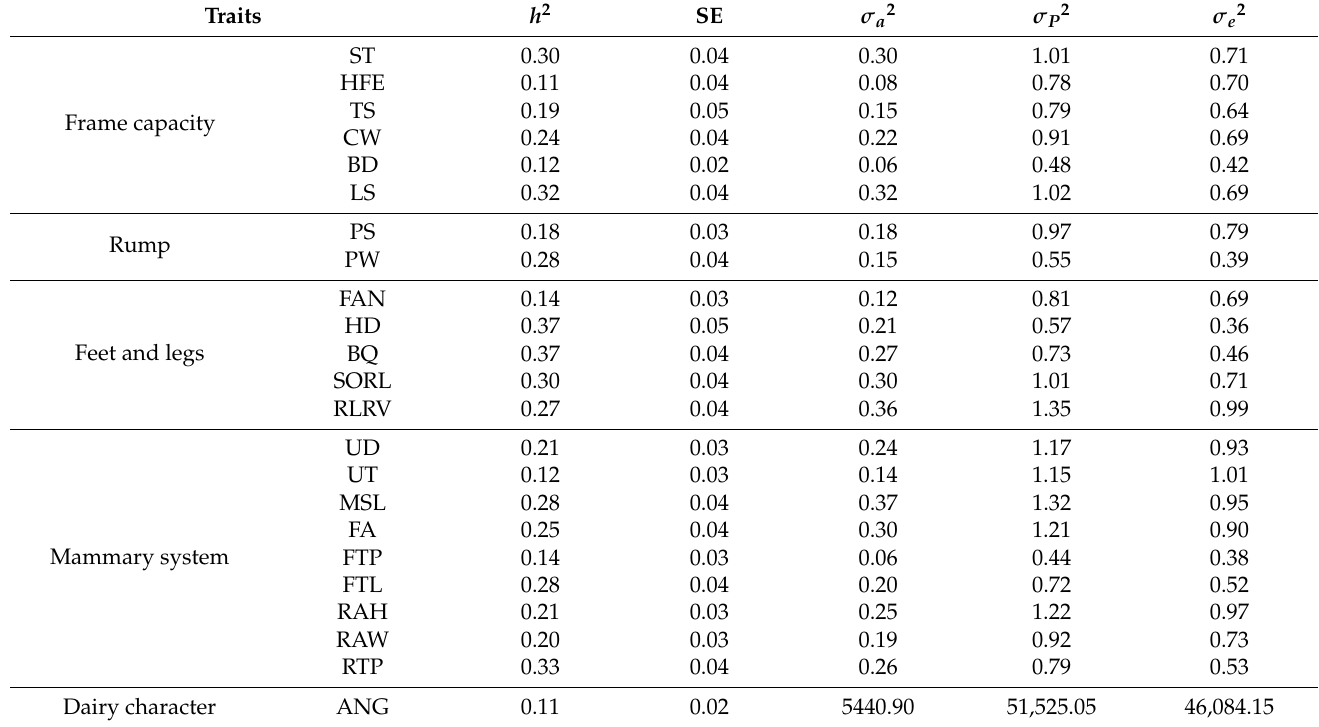
Table 4. The heritability of conformation traits 1 in Chinese Holsteins.